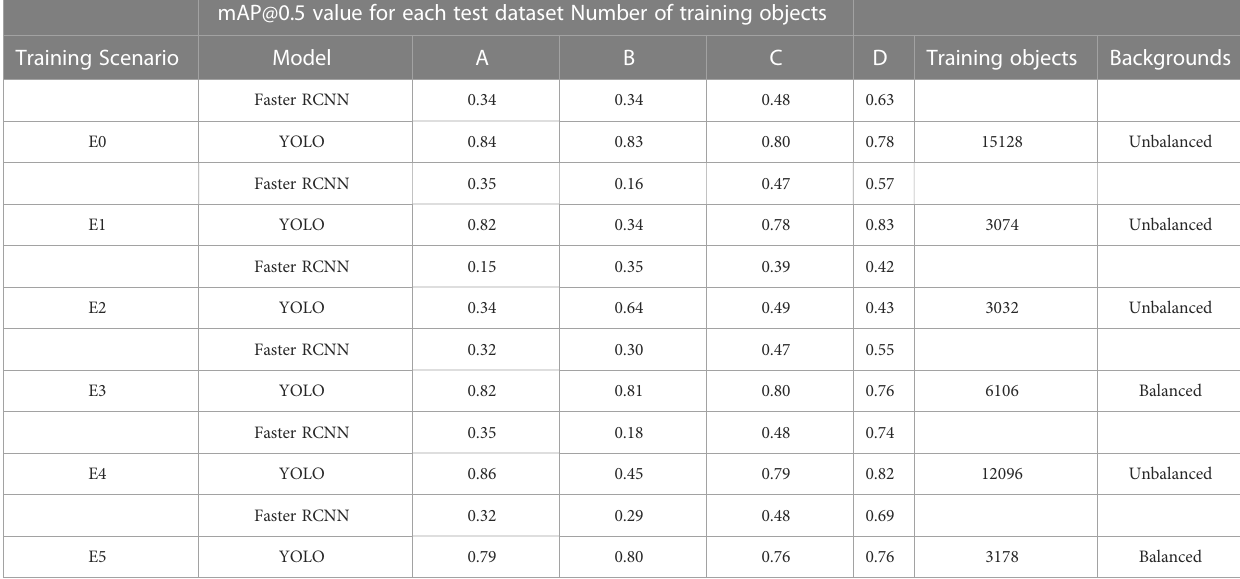
TABLE 4 Results of the application of YOLO to the four test datasets (never seen by the trained DL nets, see Table 1 ). mAP@0.5 value for each test dataset Number of training objects Training